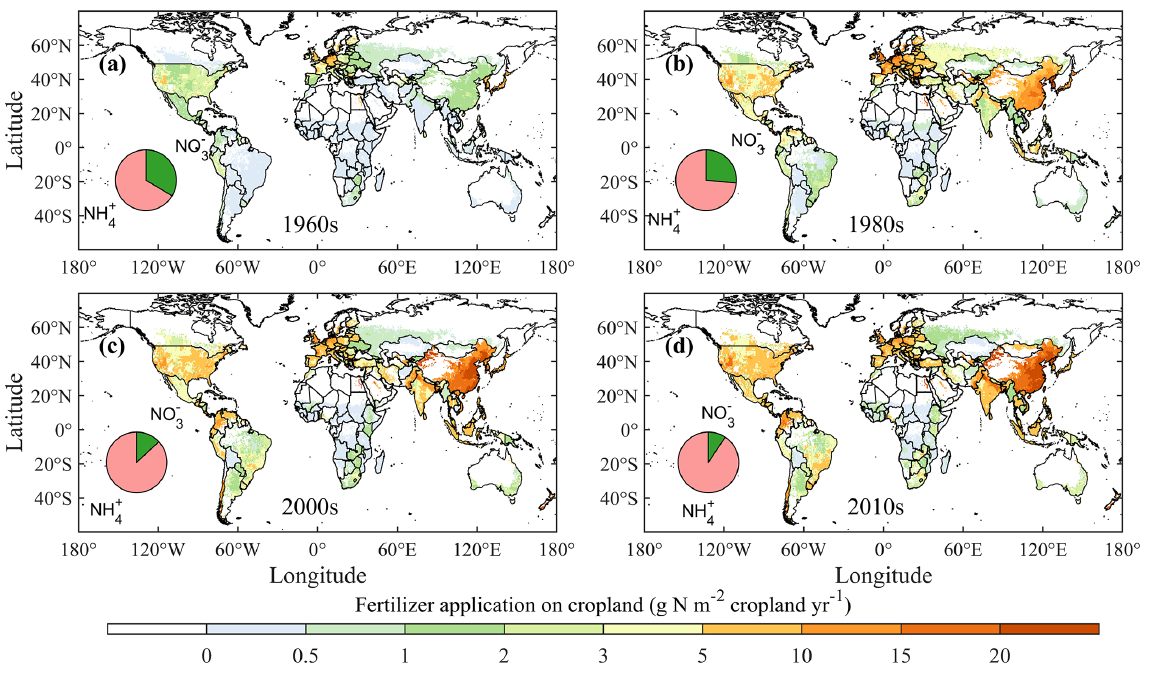
Figure 7. Spatial patterns of N fertilizer application on cropland in the 1960s, 1980s, 2000s, and 2010s.